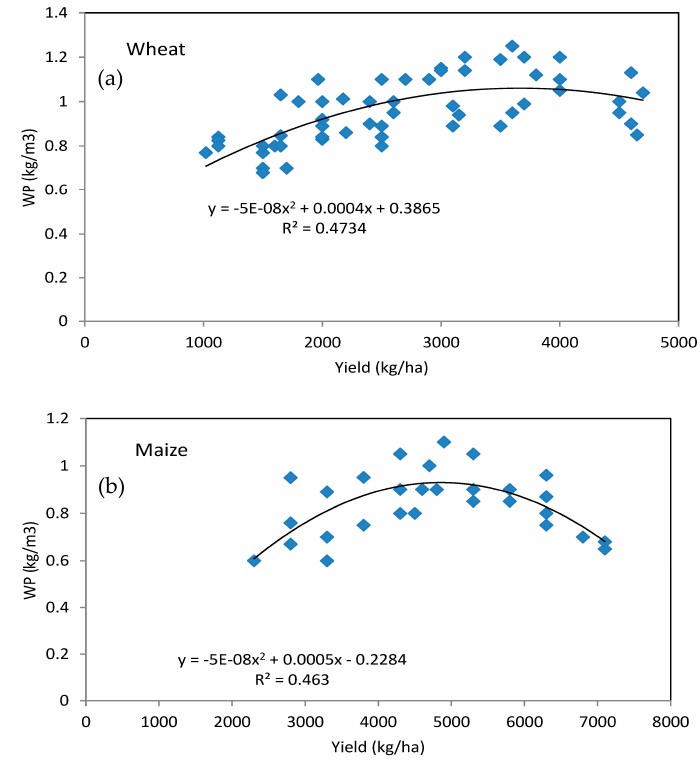
Figure 7. Relationship between yield and irrigation water applied for wheat ( a ) and maize ( b ).